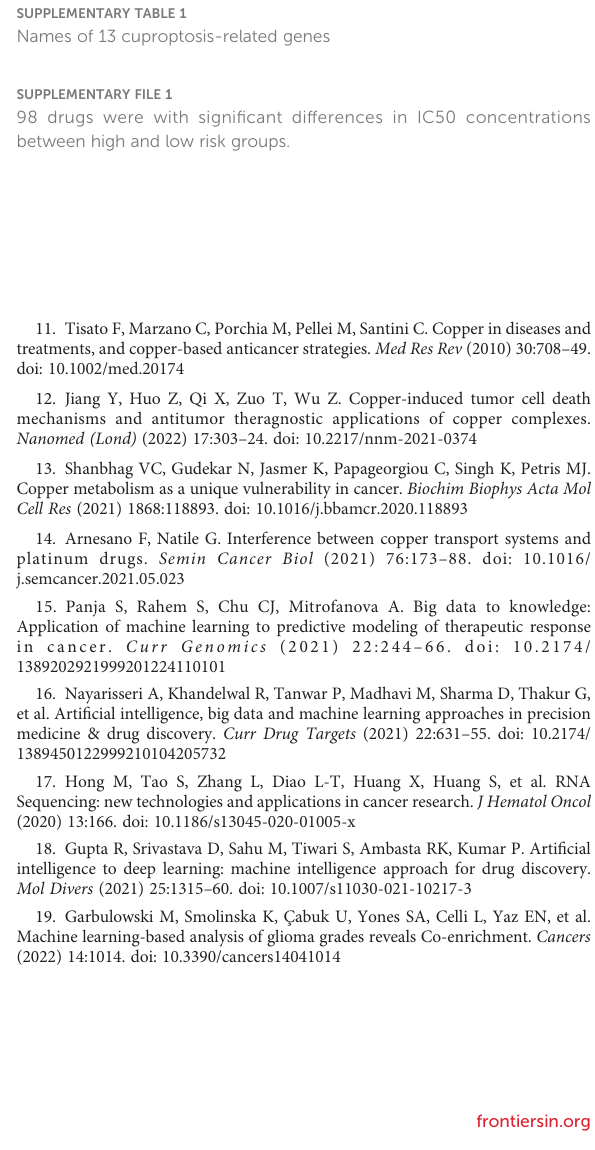
SUPPLEMENTARY FIGURE 3 Melanoma gene subtypes constructed based on prognostic-related intersection differentially expressed genes. (A) Three gene subtypes obtained by unsupervised consensus clustering method. (B) Consistent distribution of different K values described by a consistent cumulative distribution function (CDF) plot. (C) The delta area score displayed the